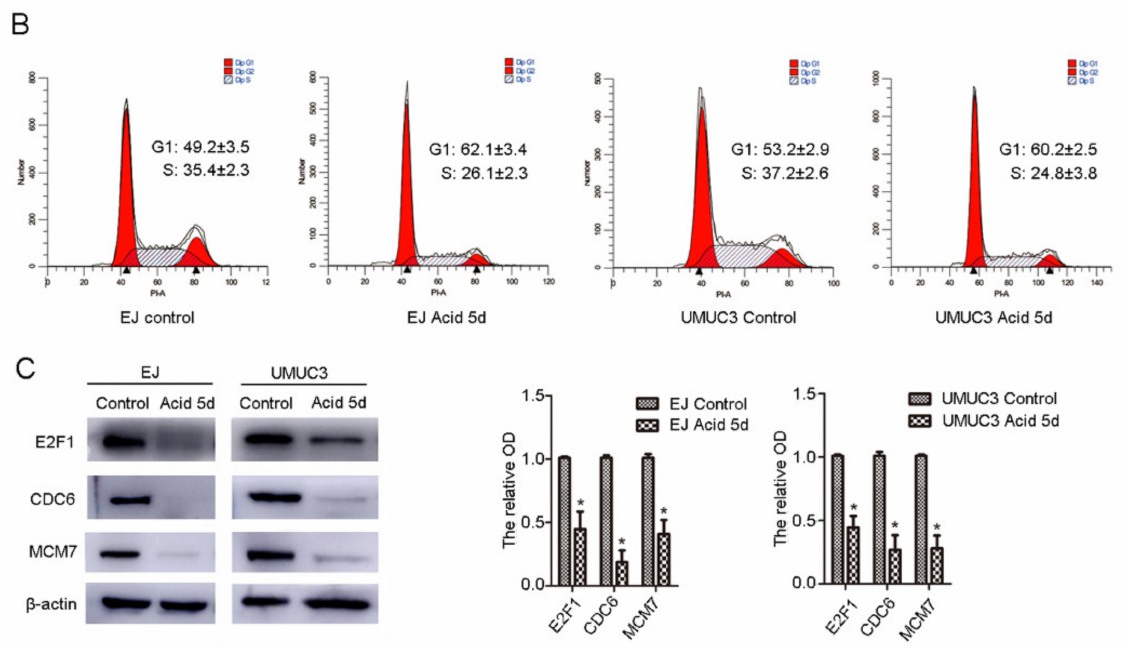
Figure 1. Bladder cancer cells enter into low-cycling state in acidic culture. ( A ) EJ and UMUC3 cells were cultured in acid medium for 3, 5, and 7 days, DNA replication was detected by EdU incorporation and observed under fluorescence microscope (100 × ). ( B ) Cells were cultured in an acid medium for 5 days, cell cycle distribution was detected by flow cytometry, and ( C ) E2F1, CDC6, and MCM7 protein levels were evaluated by western blot. β -actin was used as an internal control. Data are presented as the mean ± SD ( n = 3), * p < 0.05 vs. the control group.